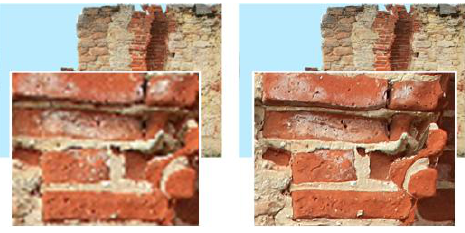
Fig. 8. Another wall of the "test" cellar